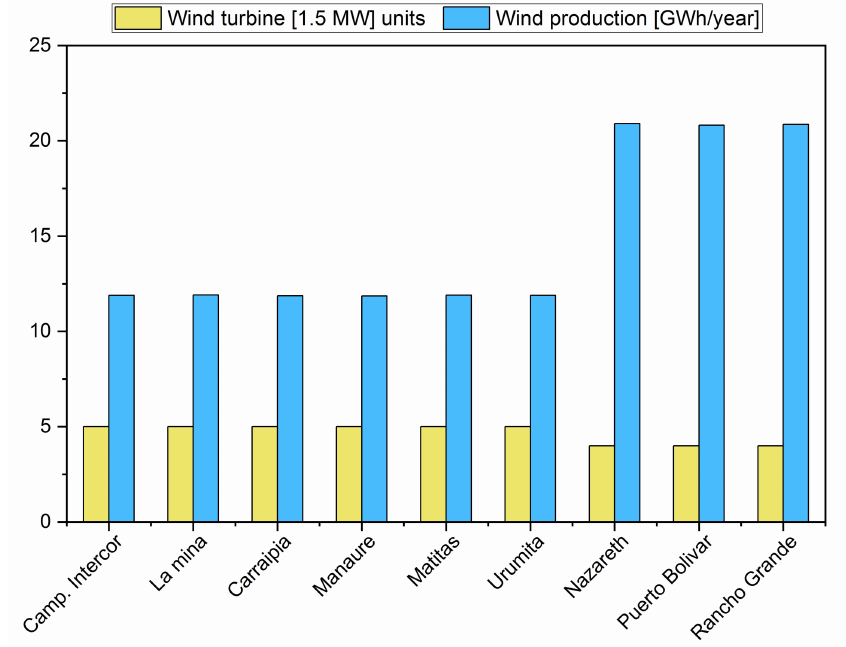
Figure 8. Comparison between the number of wind turbines and the annual energy production for each